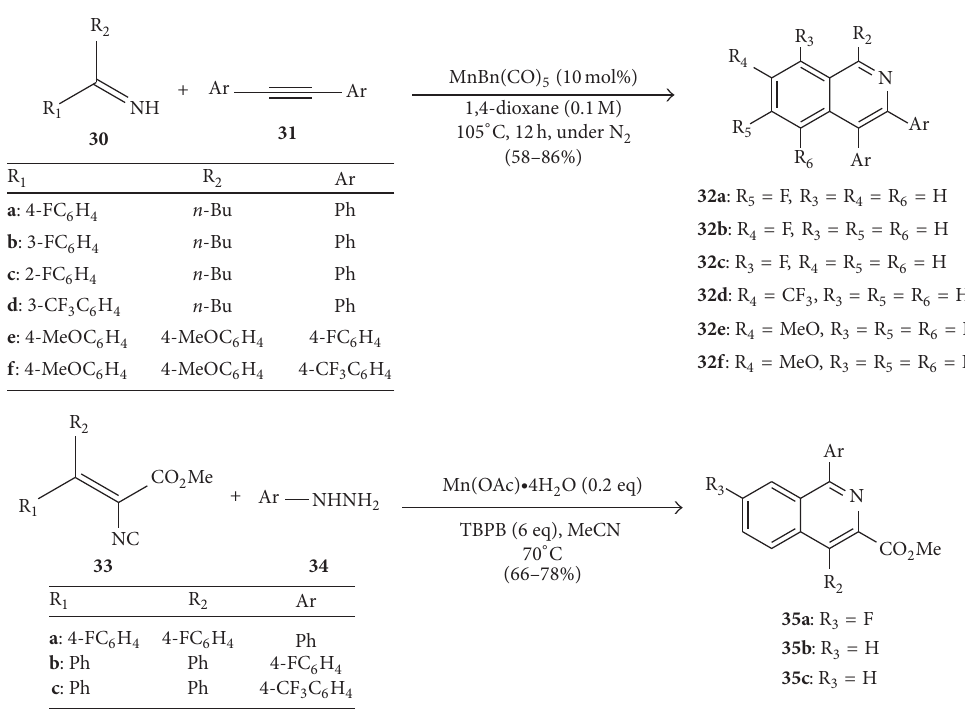
Scheme 11: Manganese catalyzed fluoroisoquinoline